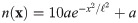
Time evolution of an epidemic starting from multiple infection centers inside a heavily populated region (“city”, panel (a)); t is the time given in days, and x and y are the spatial Cartesian coordinates. The population density of the city n is nonuniform and given by n(x)=10ae-x2/ℓ2+a, with x = (x,y), ℓ = 10, and a taken such that the spatial average of n is 0.2; see Fig SI-1 in S1 File for illustration. The integrated initial value of b (B = 10−3) is the same as in all previous figures. All other populations are initially zero: w = f = r = 0. Panels (b)-(f) show the spread of the symptomatic sub-population f as time progresses. The global sub-populations and the cumulative infected population 1 − H are shown in panels (g) and (h), respectively.